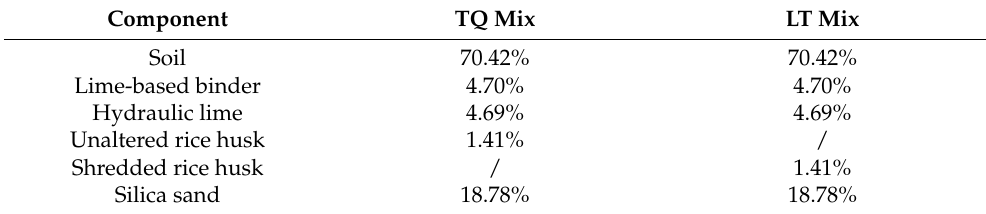
Table 1. Percentage compositions by weight of the TQ and LT mixes.